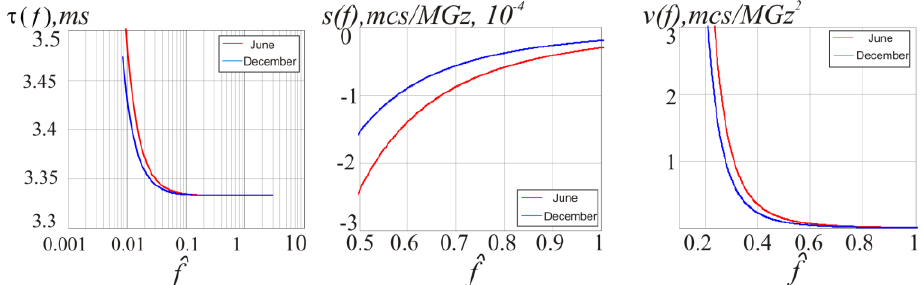
Fig. 3. Dispersion parameter variations in a transionospheric radio channel estimated with the use of